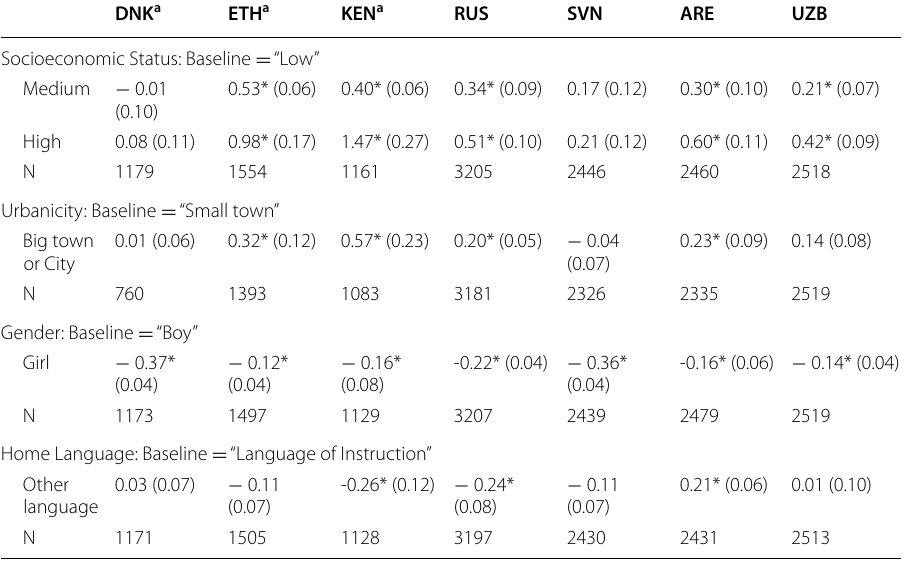
Table 4 Inequalities in self‑efficacy in technology use scale